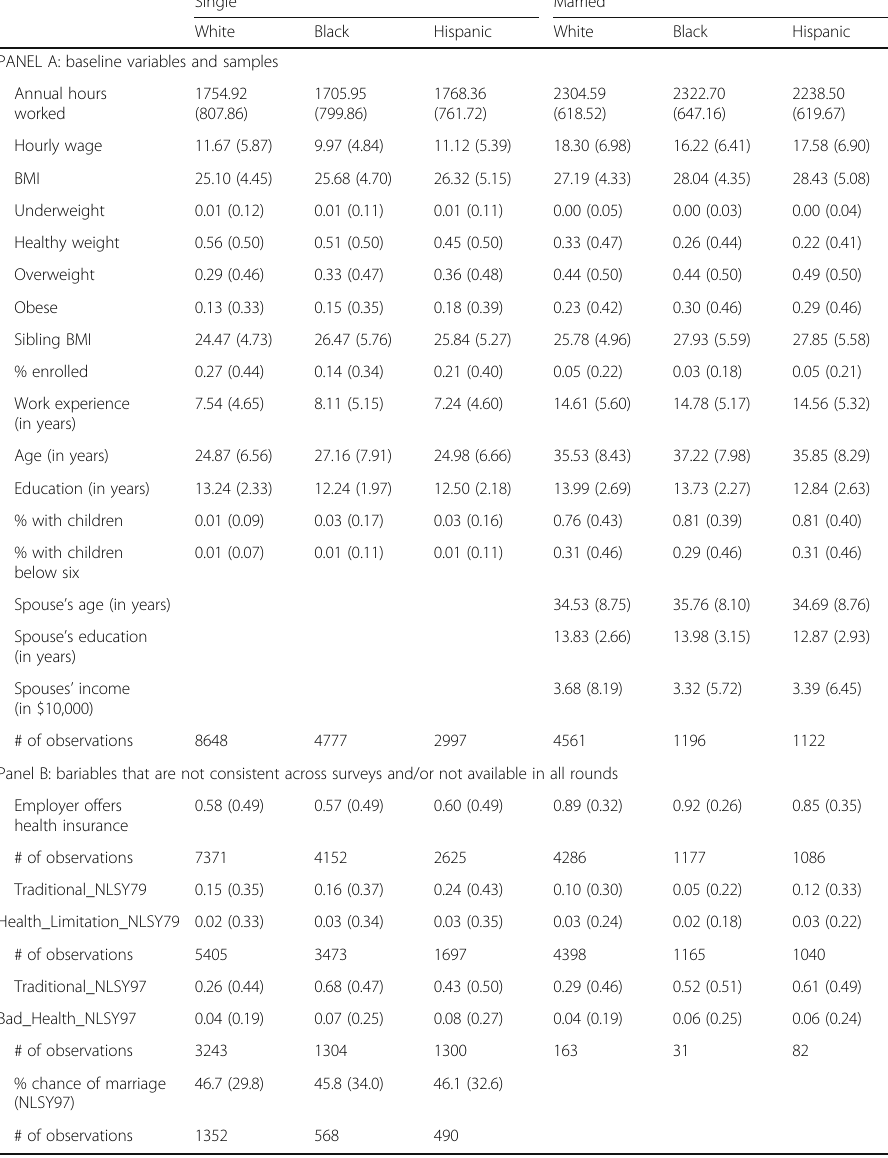
Table 9 Summary statistics for